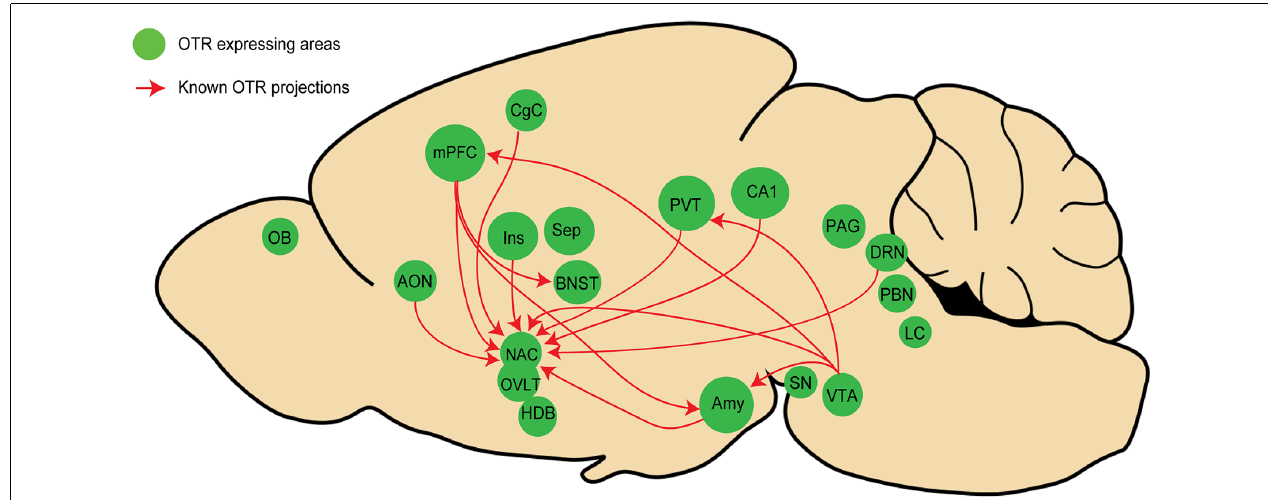
FIGURE 2 | Schema representing the known inter areas OT receptor (OTR) network in rodents. Regions in green contain OTR neurons, red arrows represent OTR projections in other regions containing OTR neurons. Note that only four studies (see text) have analyzed OTR projections, mostly focusing on the NAcc, indicating that numerous OTR connections have not been yet discovered. See Figure 1 legends for abbreviations.